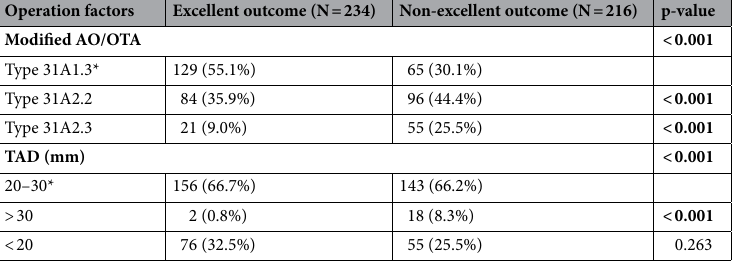
Table 3. Percentage of excellent and non-excellent outcomes by surgical factors. *Reference; TAD Tip Apex Distance, mm millimeters. The outcome assessed by HHS. Significant values are in bold.